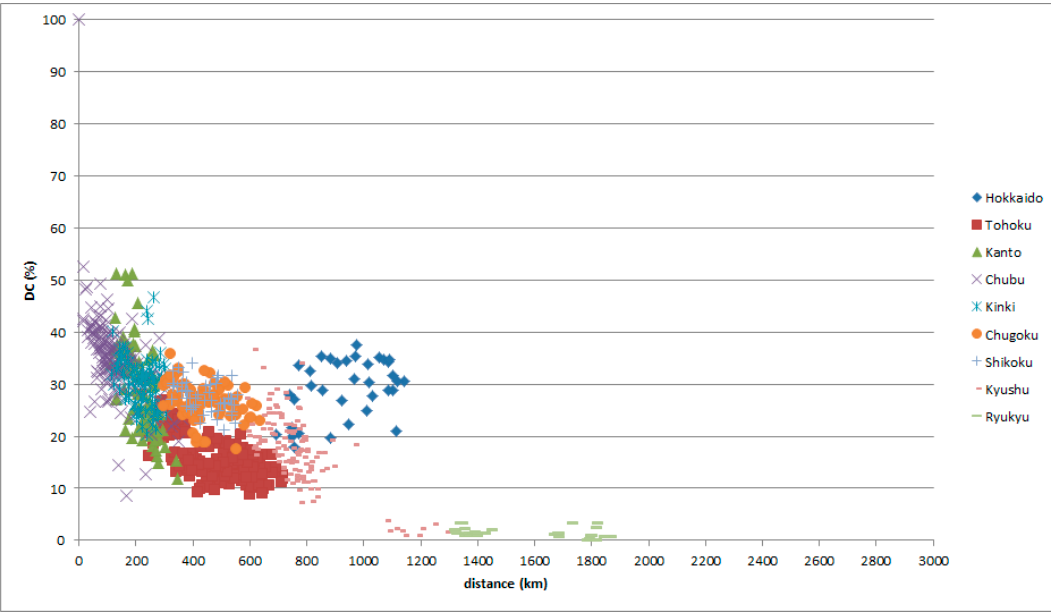
Figure 11. GAJ data with reference place in Tokaitosan, classified by comparison place.